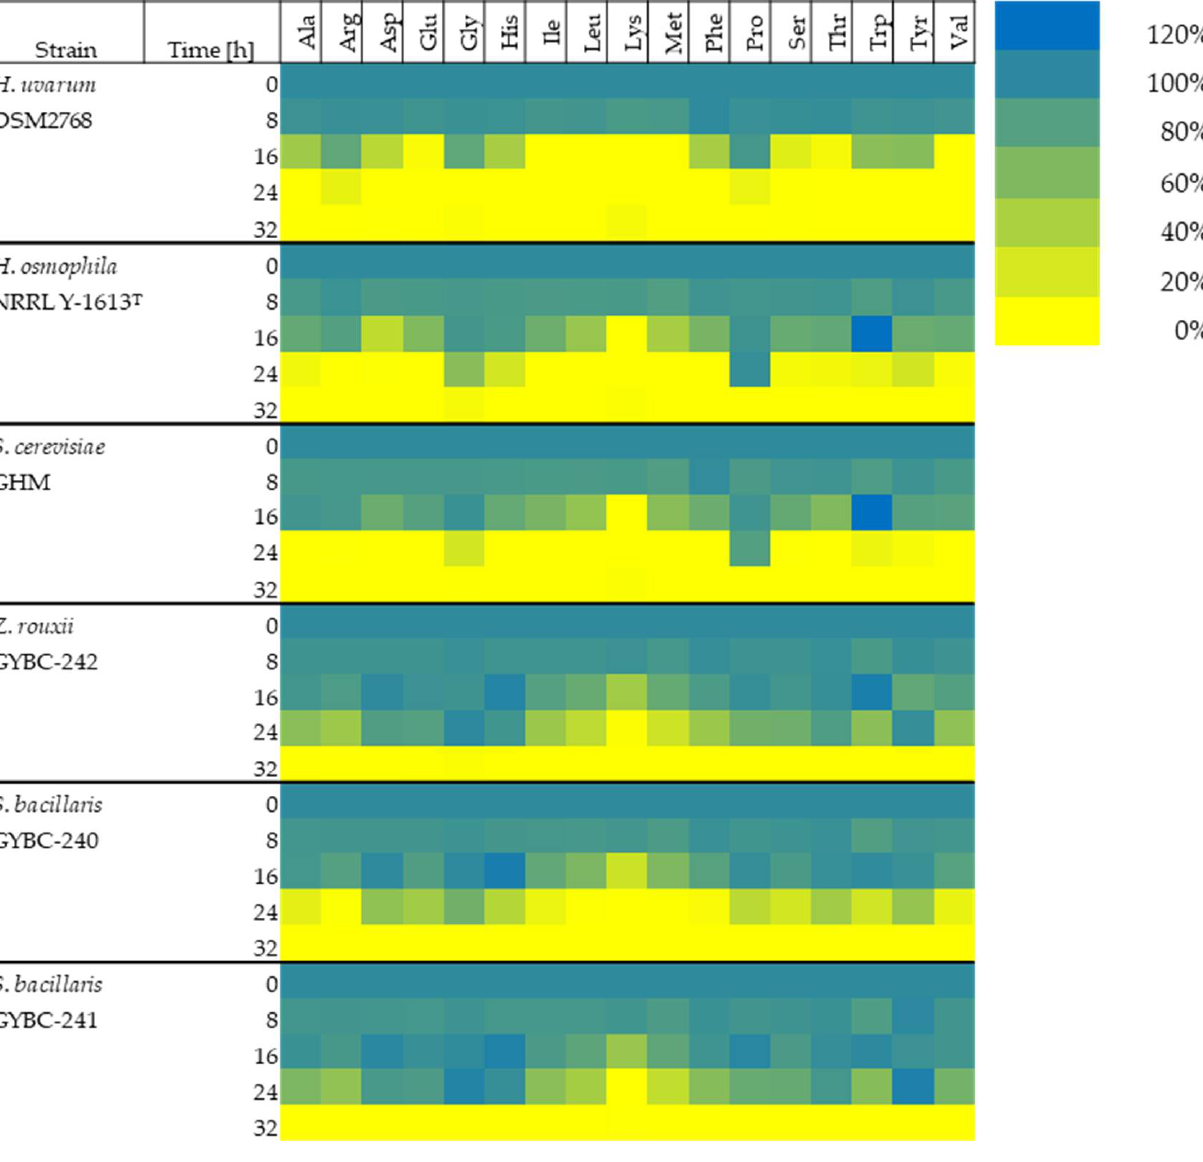
Figure 3. Amino acid concentration (%) present in the medium at different time points of the alco- holic fermentation in SM-mix. The initial concentration of each amino acid is expressed as 100%. It should be noted that the values of Glu also contained Gln and Asp also contained Asn. Cys could not be